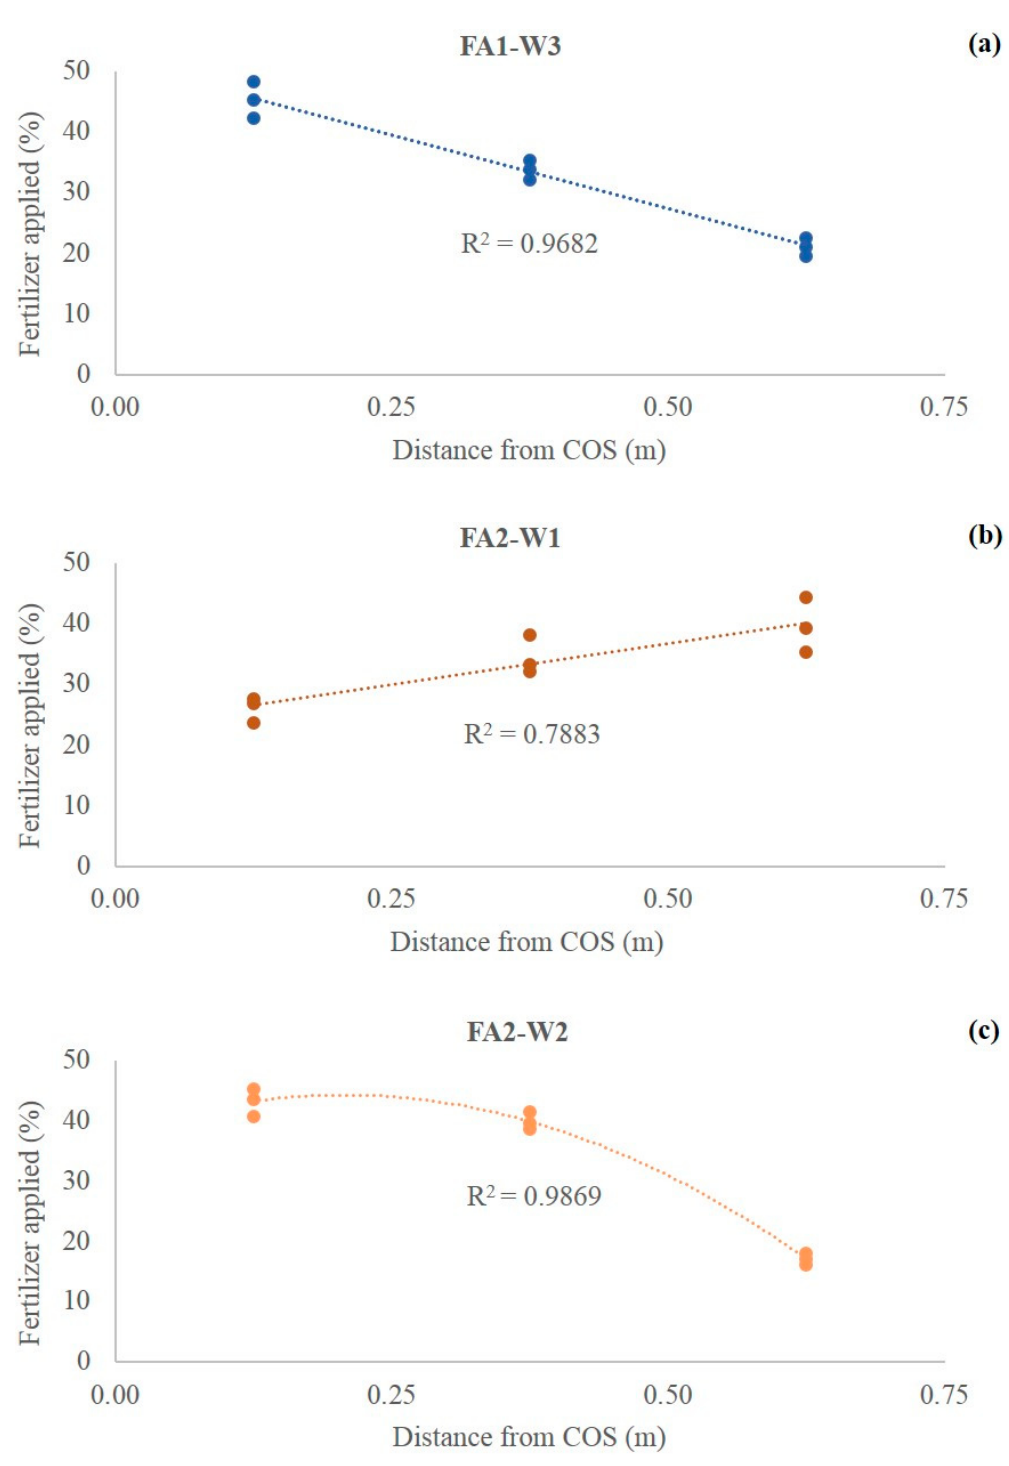
Figure 6. Regression slopes for the percentage of fertilizer applied relative to the distance from the orthotropic stem of the co ff ee plants (COS) showing the average values for each fertilizer dose (200, 300 and 400 kg ha − 1 ) and considering the following treatments: ( a ) FA1-W3, application on one side of co ff ee plants at a disk rotation speed of 750 rpm; ( b ) FA2-W1, application on both sides of co ff ee plants at a disk rotation speed of 240 rpm; ( c ) FA2-W2, application on both sides of co ff ee plants at a disk rotation speed of 375 rpm.